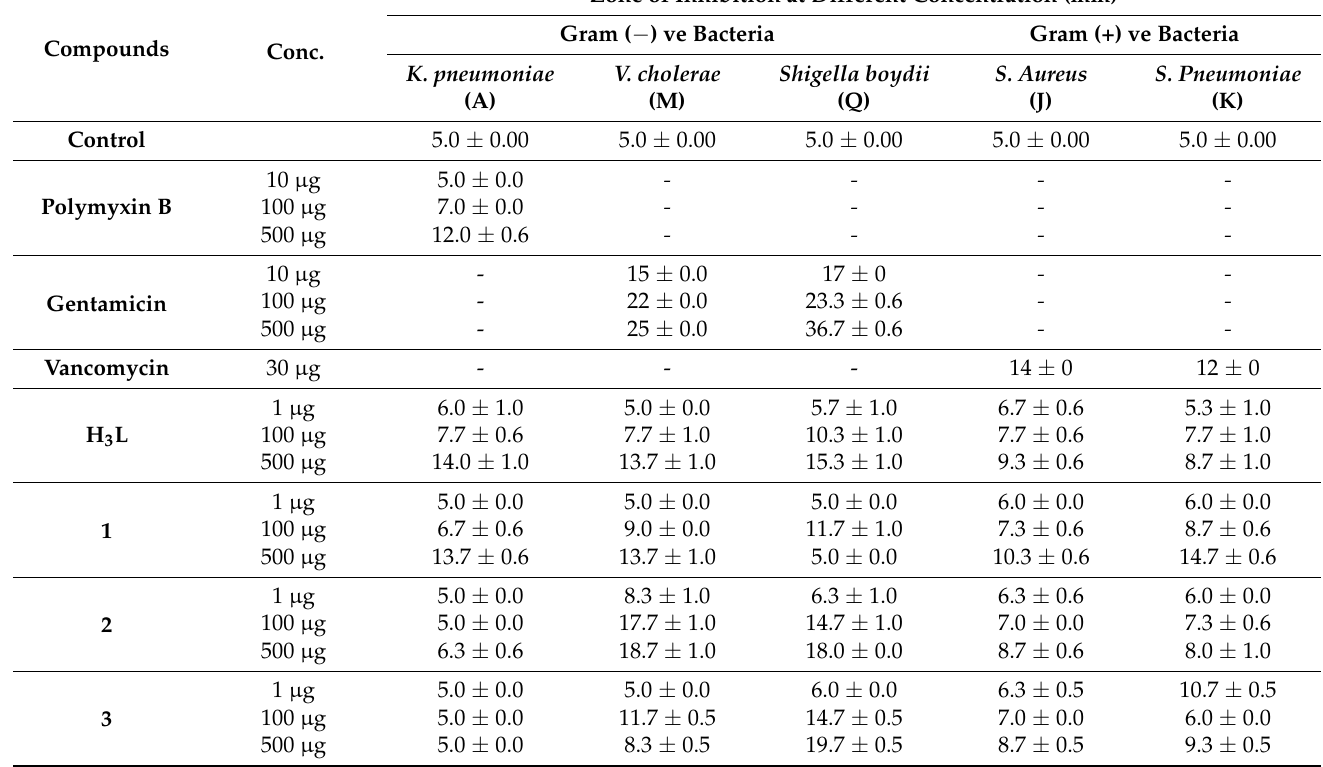
Table 5. Antibacterial activities of the compounds and standard drugs against three ( − ) ve and two (+) ve bacteria.